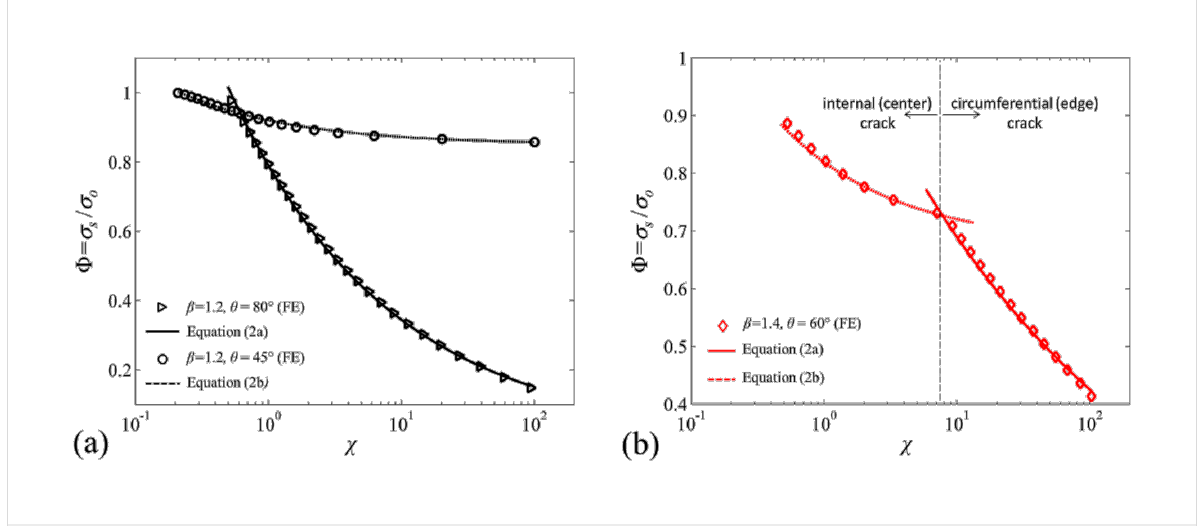
Figure 6: (a) Simulation results (triangle markers) for β = 1.2, θ = 80° for which a crack initiates at the edge for all χ . Solid line represents Equation 2a with B e = 0.84 and α = 0.36. Also included are the simulation results (circle markers) for β = 1.2 and θ = 45° for which a crack initiates at the center for all χ . Dashed line represents Equation 2b with B c = 0.076 and Γ c = 0.85. (b) Simulation results for β = 1.4, θ = 60° for which a crack initiates at the edge for χ > 7 and at the center for χ < 7. Solid line represents Equation 2a with B e = 1.2 and α = 0.21. Dashed line represents Equation 2b with B c = 0.17 and Γ c =